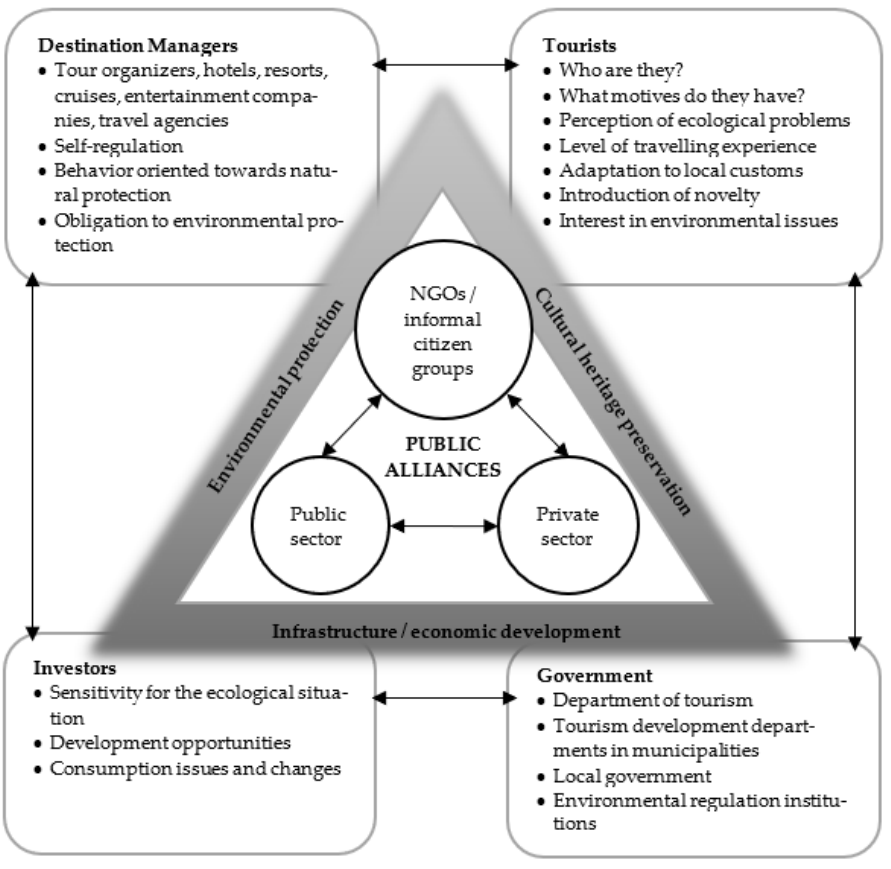
Figure 3. Relationship-Based Paradigm of Sustainable Tourism by Hassan (2000). Source: Hassan 2000. Determinants of Market Competitiveness in an Environmentally Sustainable Tourism Industry. Journal of Travel Research 38: